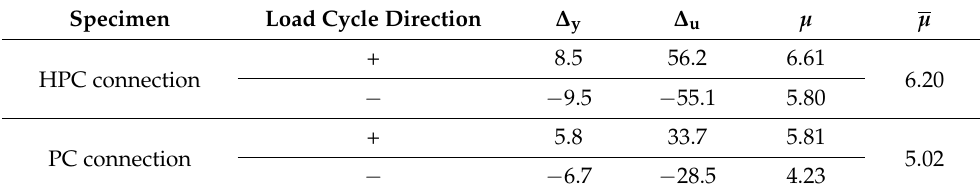
Table 2. Ductility coefficients of the connections.